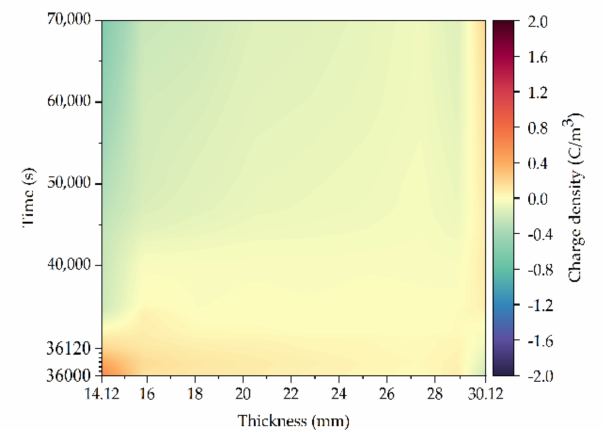
Figure 10. Space charge evolution in the HVDC extruded cable at a load current of 800 A, under the applied DC voltage shown in Figure 3 with a PRP of 120